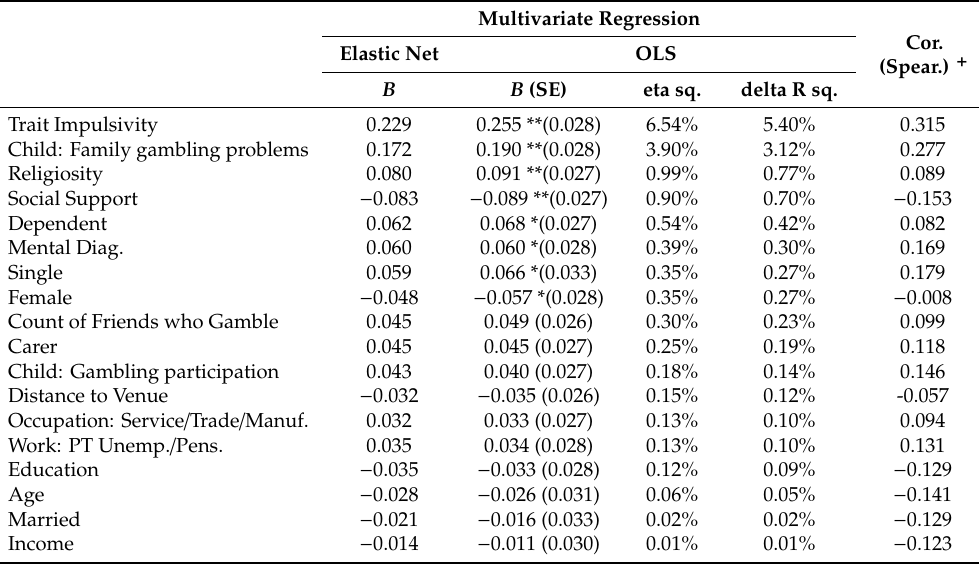
Table 2. Bivariate correlations, ordinary least squares (OLS) and ‘elastic net’ EN multivariate regressions of distal risk factors on gambling-related